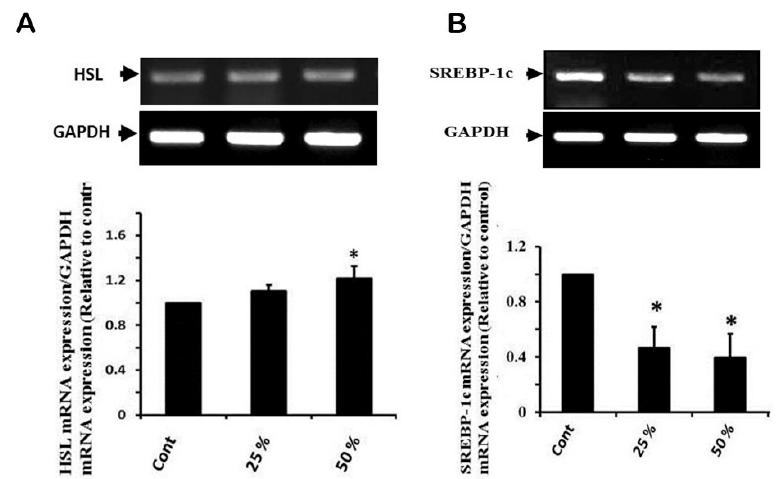
Figure 3. Effect of ginger water on HSL ( A ) SREBP-1c, ( B ) mRNA expressions in hepatic tissue of rats. Results of densitometric analyses and demonstrative blots of at least five independent experiments are displayed. Values are expressed as means ± SE. Cont: control, 25%:25% ( v / v ) ginger water-treated group, 50%:50% ( v / v ) ginger water-treated group. * p < 0.05 vs. the control.